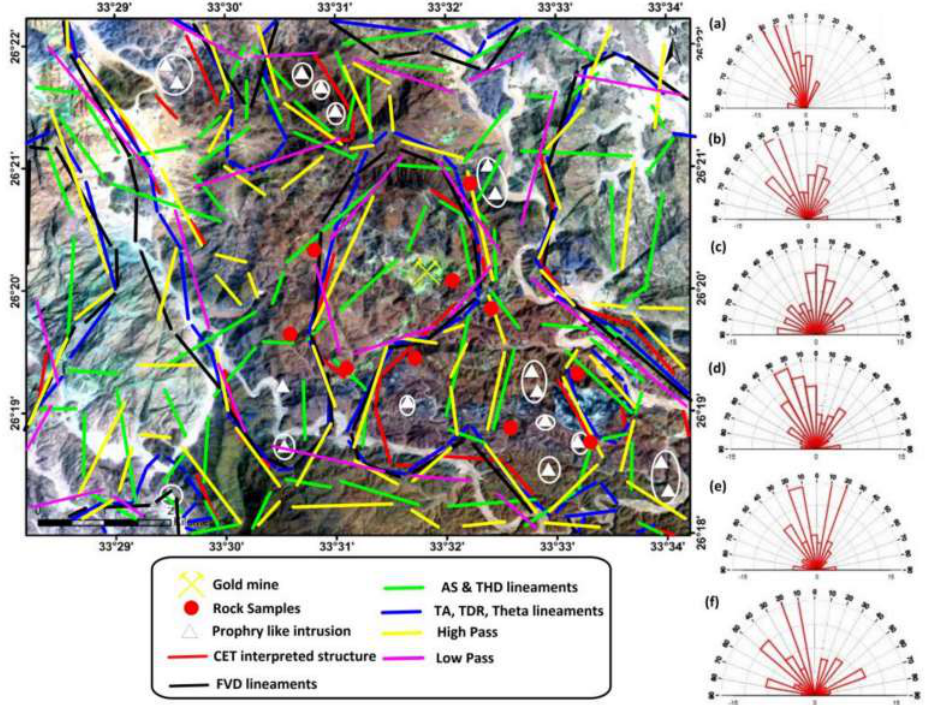
Figure 13. This map shows the faults, contacts, and dykes beneath the surface of the region under study from ( a ) the CET grid analysis, ( b ) FVD, ( c ) AS and THD, ( d ) TA, Theta, and TD, ( e ) the high-pass, and ( f ) the low-pass maps. The rose diagrams display the primary and minor trends of the subsurface